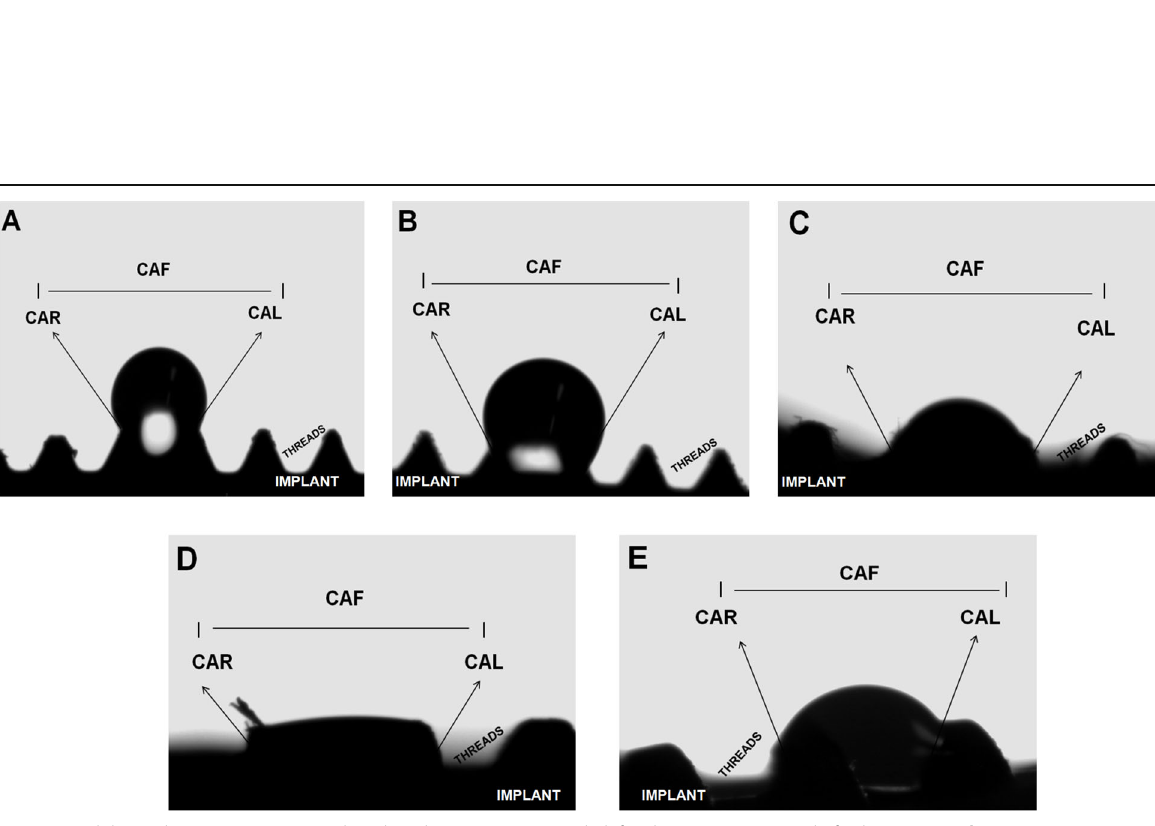
Fig. 2 Wettabilty analysis. CAR, contact angle right side; CAL, contact angle left side; CAF, contact angle final; a Nanotite. b Osseotite. c SLActive. d Acqua. e Cone Morse